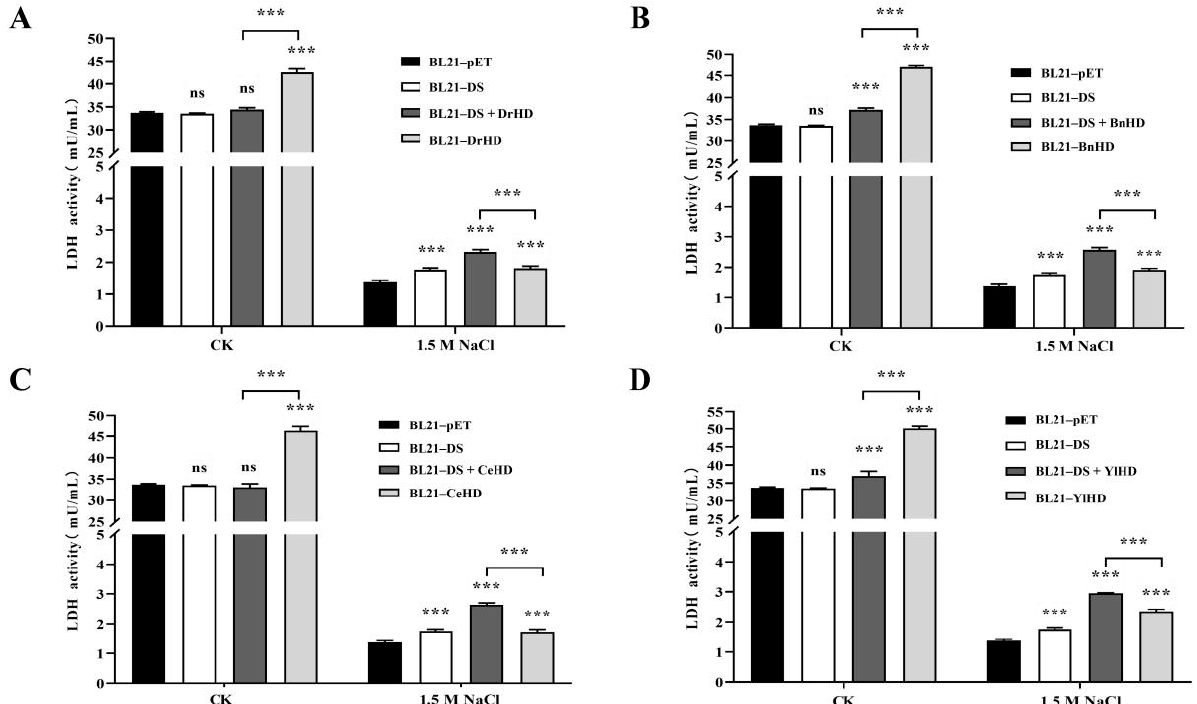
Figure 5. Lactate dehydrogenase activity analysis. ( A ) Analysis of lactate dehydrogenase activity of recombinant strains BL21-DS + DrHD and BL21-DrHD. ( B ) Analysis of lactate dehydrogenase activity of recombinant strains BL21-DS + BnHD and BL21-BnHD. ( C ) Analysis of lactate dehydrogenase activity of recombinant strains BL21-DS + CeHD and BL21-CeHD. ( D ) Analysis of lactate dehydrogenase activity of recombinant strains BL21-DS + YlHD and BL21-YlHD. The symbols ‘ns’ and ‘***’, respectively, represent ‘no significantly different ( p > 0.05)’, ‘a significant difference (0.01 < p < 0.05)’, ‘an extremely significant difference (0.001 < p < 0.01)’, and ‘the most significant difference ( p < 0.001)’.